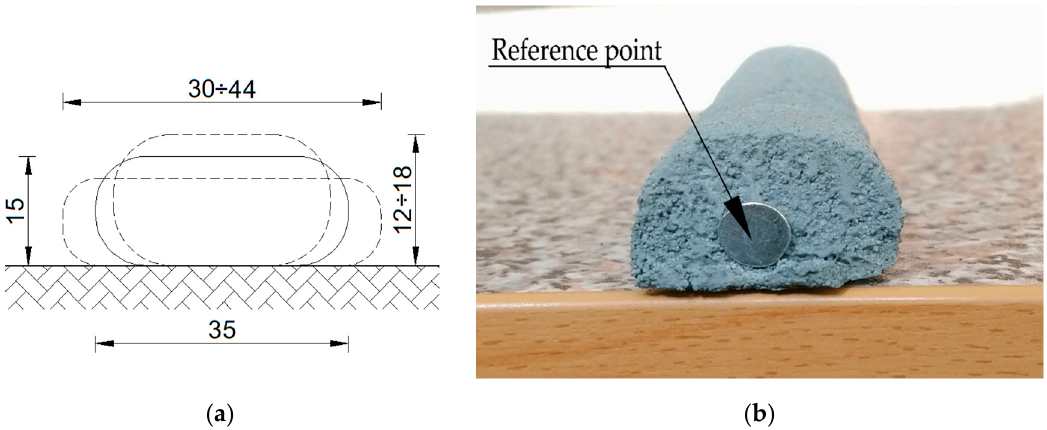
Figure 2. Specimen cross-sections: ( a ) diagram; ( b ) actual printed matter containing the reference point.